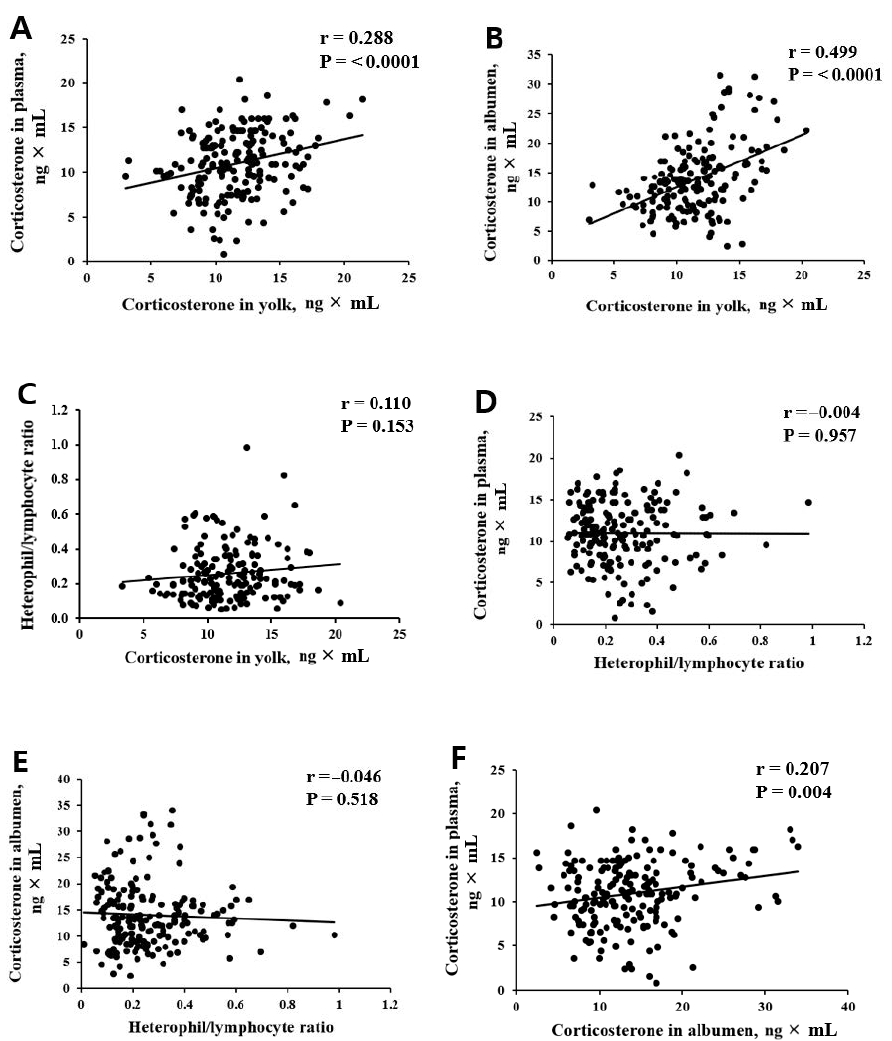
Figure 4. Correlation between ( A ) corticosterone in yolk and corticosterone in plasma, ( B ) corticos- terone in yolk and corticosterone in albumen, ( C ) corticosterone in yolk and heterophil to lymphocyte ratio, ( D ) heterophil to lymphocyte ratio and corticosterone in plasma, ( E ) heterophil to lymphocyte ratio and corticosterone in albumen, and ( F ) corticosterone in albumen and corticosterone in plasma.